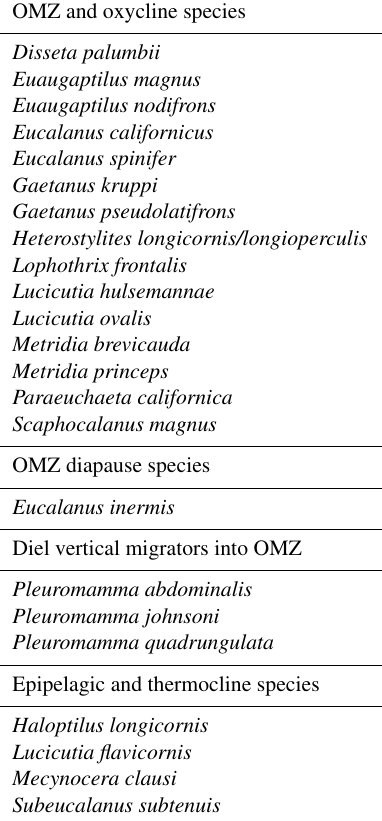
Table 2. Copepod species discussed in this paper. OMZ and oxycline